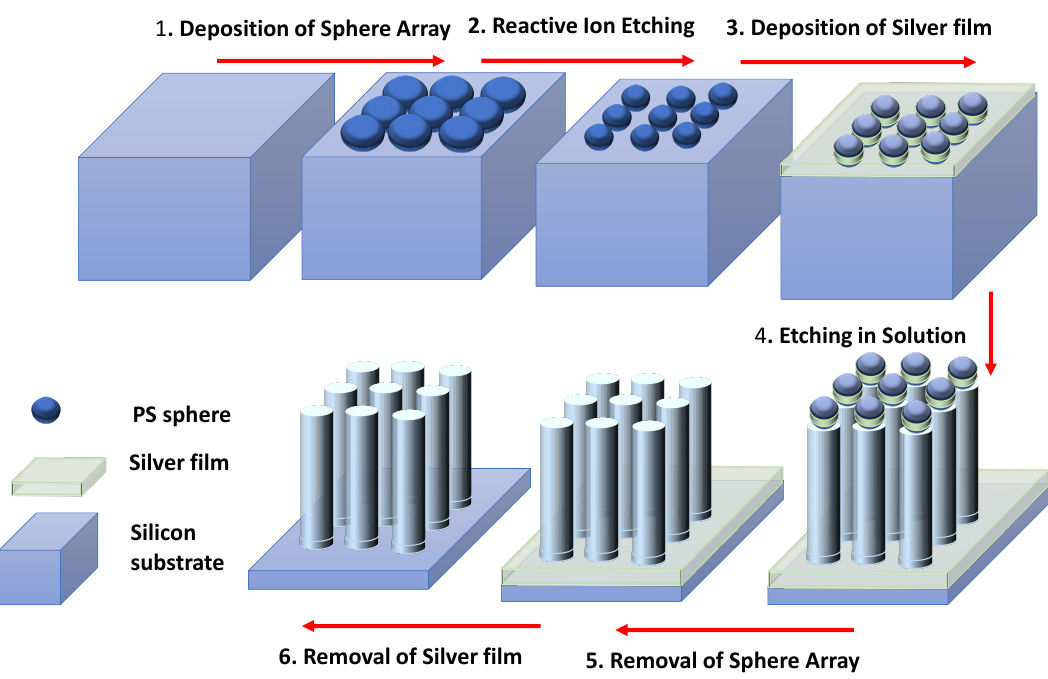
Figure 3. Schematic diagram for the fabrication of SiNW by etching